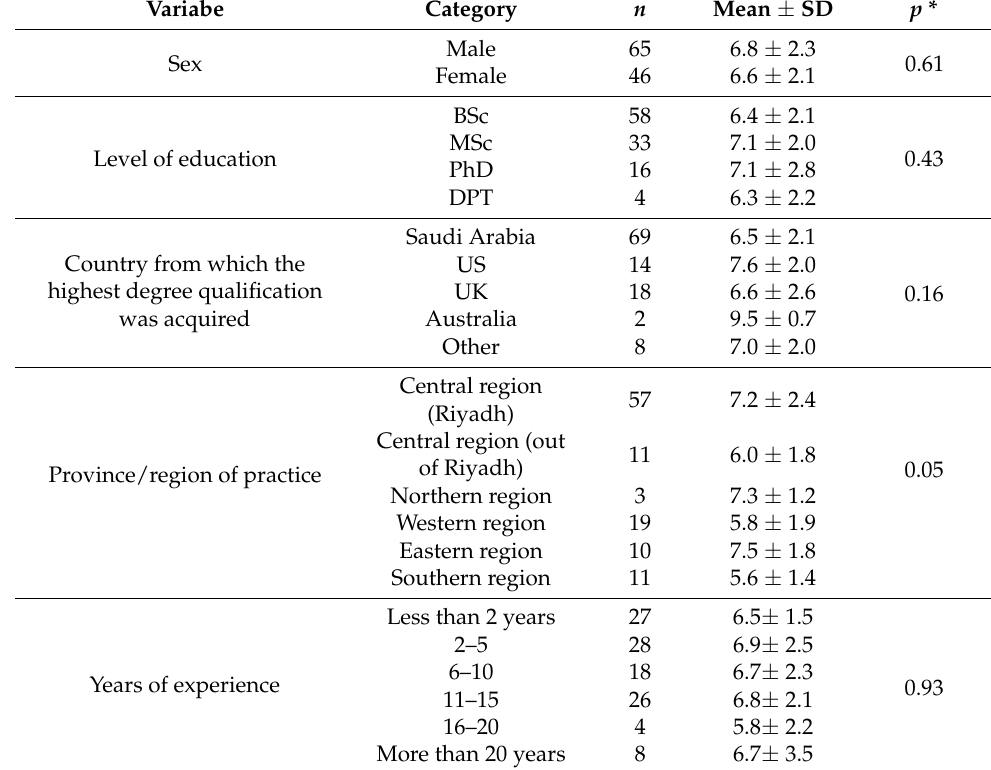
Table 2. Scores on the Revised Neurophysiology of Pain Questionnaire, by participants’ personal and professional